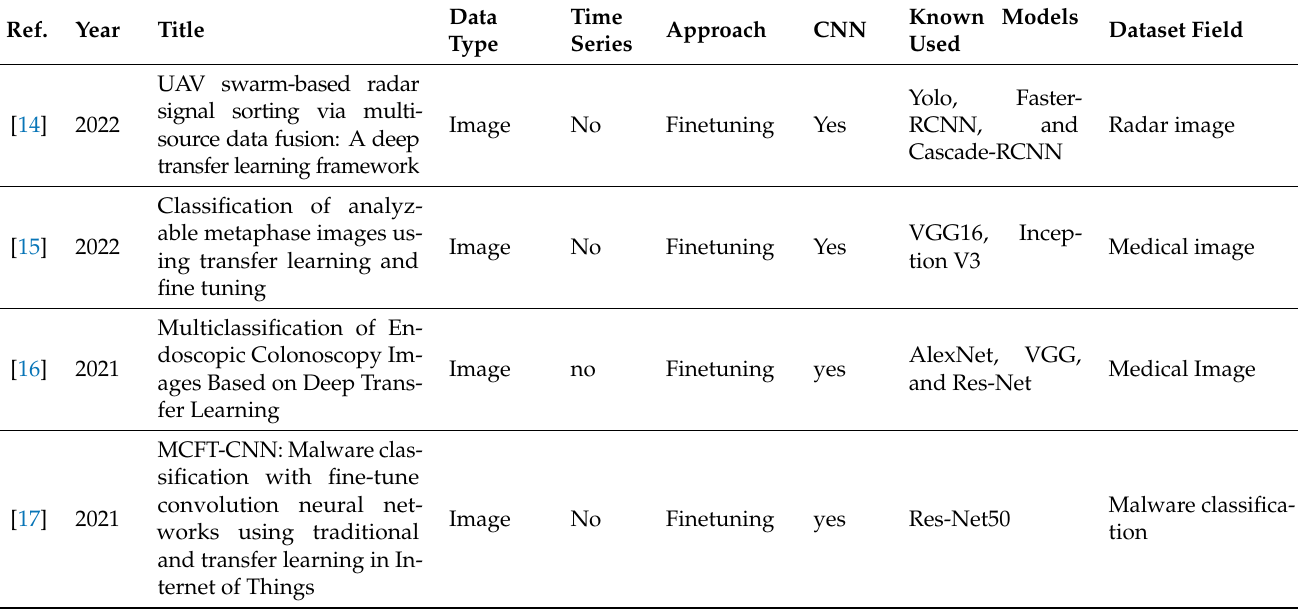
Table 1. List of selected recent deep transfer learning (DTL)